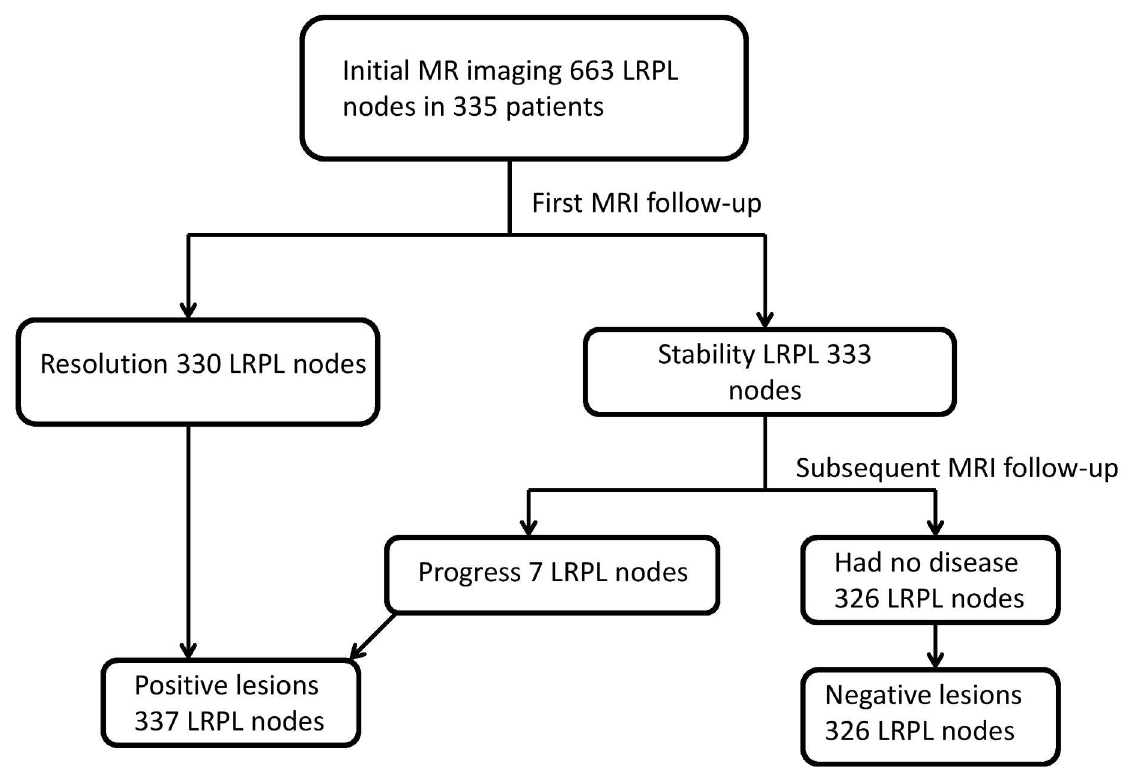
Fig 2. Stage I flowchart of MRI follow-up. Diagnostic results of MRI follow-upfor 663 nodes in 335 patients with data on three diameters from MRI.